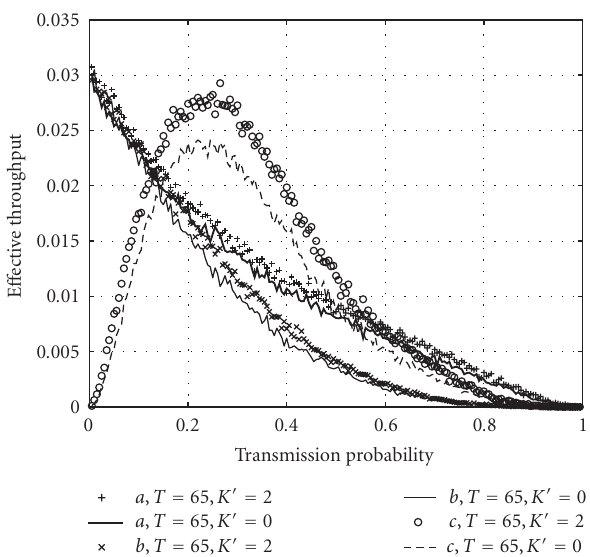
Figure 25: The e ff ective throughput of the dynamic ( K (cid:5) = 2) and the static ( K (cid:5) = 0) cases for K = 4 and T = 65 (connections a , b , and c of the asymmetric network of Figure 11).